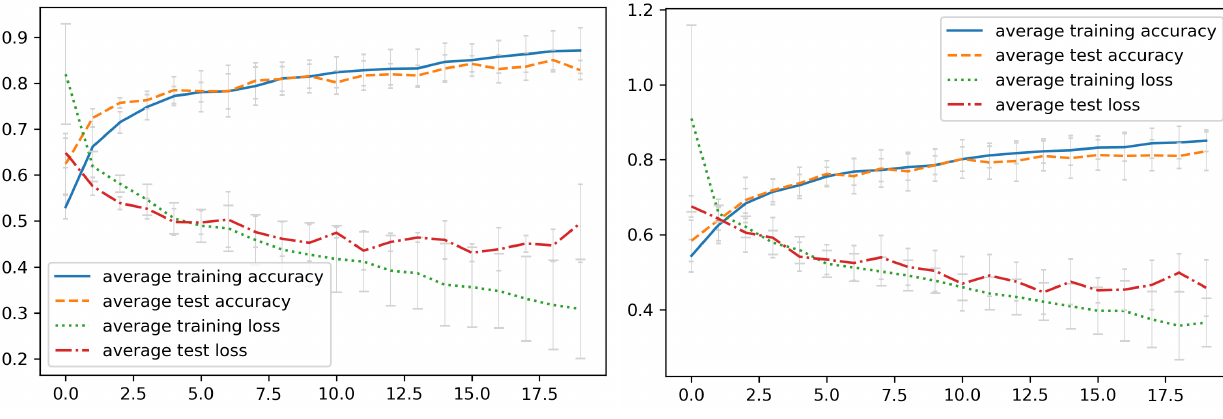
Figure 13. Left image: single dropout. Right image: double dropout. Summary of average results for 20 iterations. Class 0 vs. II. Single dropout. Model: the LeNet model from Figure 5 was applied. Cross-validation 5. Accuracy for 20 iterations of neural network training and corresponding cross-entropy